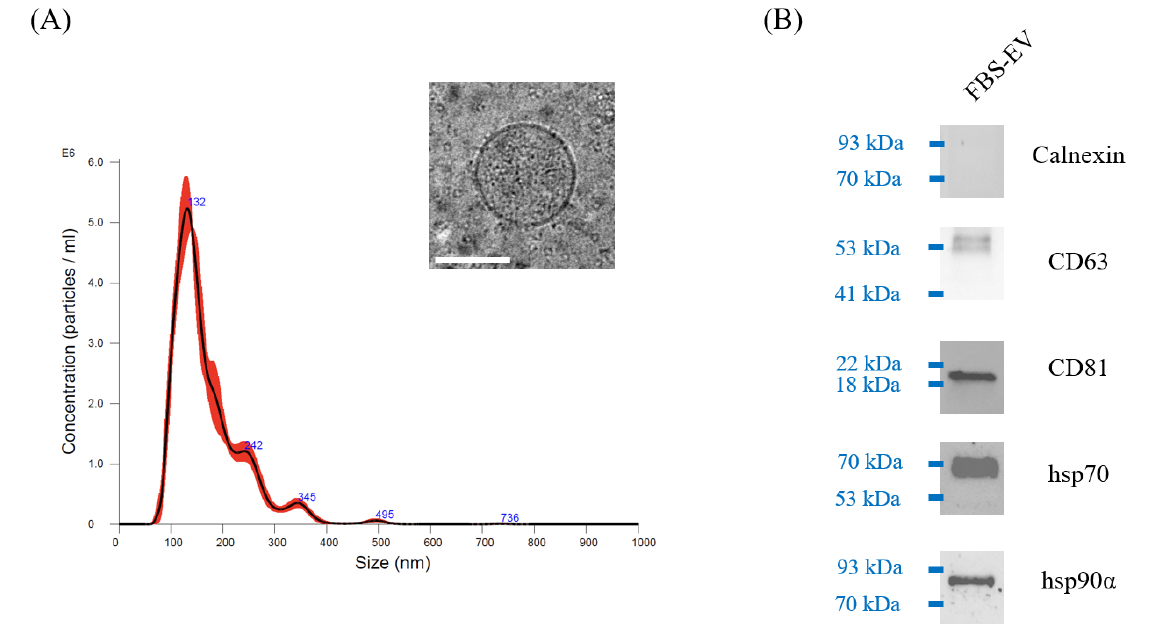
Figure 1. Characterization of FBS-EVs. ( A ) NTA results for FBS-EVs. Cryo-TEM image of FBS-EVs (inset). Scale bar = 100 nm. ( B ) Western blotting results for FBS-EVs.